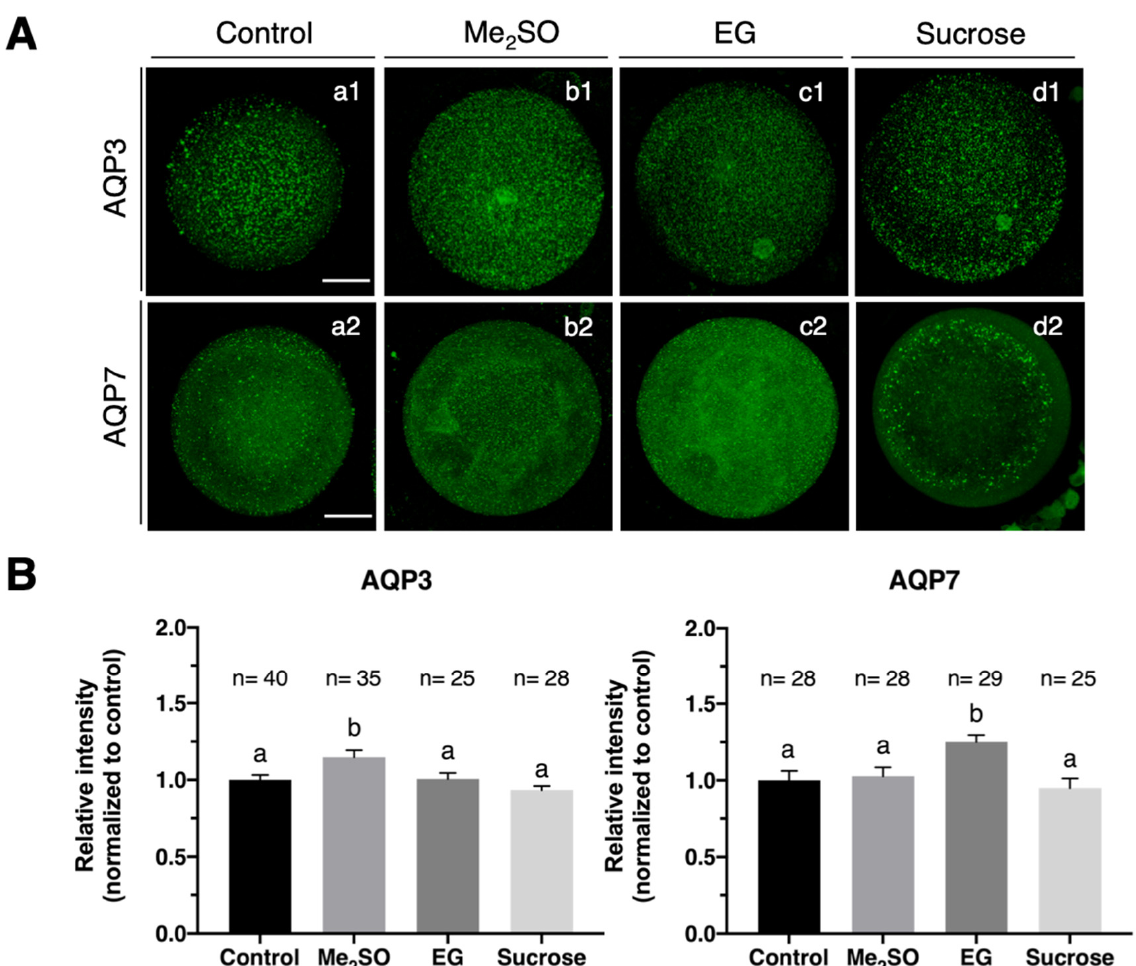
Figure 2. Effect of the exposure of IVM bovine oocytes to hyperosmotic CPA solutions on the levels of expression of AQP3 and AQP7. ( A ) Immunofluorescence analysis of AQP3 and AQP7 expression in bovine oocytes without treatment (a1 and a2, respectively) and in the presence of 9.5% Me 2 SO (b1 and b2, respectively), 8% EG (c1 and c2, respectively) or 0.5 M sucrose (d1 and d2, respectively). The concentrations of the two penetrating cryoprotectants, EG and Me 2 SO, were chosen to prepare solutions with similar osmolalities, as previously indicated [15]. AQP3 and AQP7 protein expression is displayed in green. Scale bar, 30 µ m. ( B ) Summary data of the relative immunofluorescence intensity normalized to control. Data are presented in arbitrary units ± SEM, n ≥ 25, a,b Different letters indicate statistically significant differences between treatments ( p < 0.05). The relative fluorescence intensity of AQP7 protein was significantly higher in oocytes injected with EGFP+AQP7 cRNA (1.37 ± 0.04) when compared to non-injected or EGFP cRNA-injected oocytes (1.02 ± 0.07), while no difference in relative immunofluorescence in- tensity was observed for AQP7 in EGFP cRNA-injected and non-injected oocytes (1.02 ± 0.07 and 1 ± 0.04, respectively) (Figure 3). These results indicate that AQP7 protein can be synthesized and overexpressed in bovine oocytes during in vitro